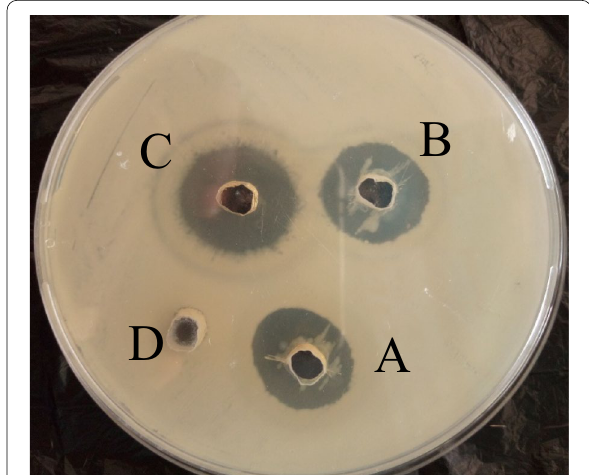
Fig. 4 Antibacterial activity of aqueous extract of V. amygdalina leaf against Streptococcus pyogenes . Keys: A C 100 mg/ml, D negative control. Negative control = =